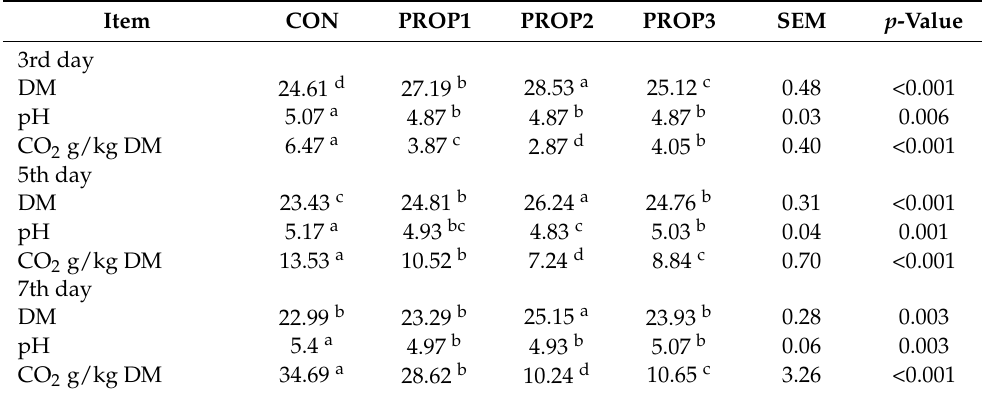
Table 7. Aerobic stability test results of alfalfa silages.